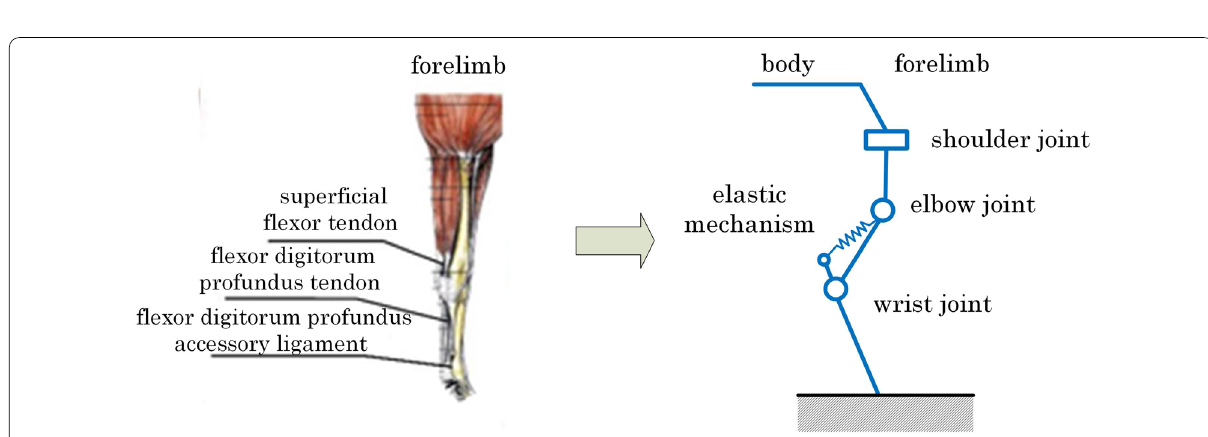
Figure 5 Bionic mapping of a tendon–ligament buffer system